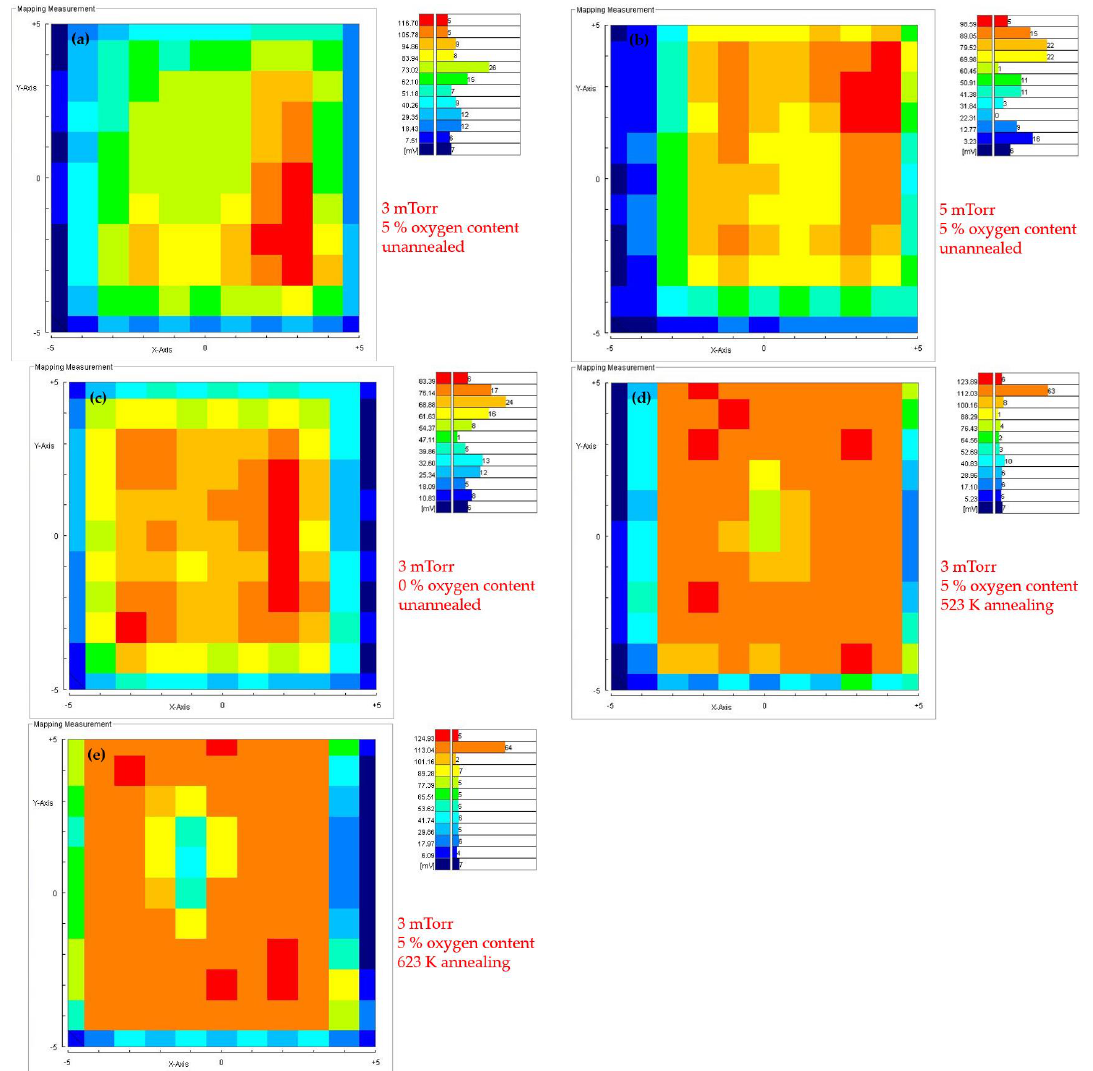
Figure 5. Images of μ-PCD mapping scan of ZATO films at different pressure, oxygen contents and annealing tempera- tures.